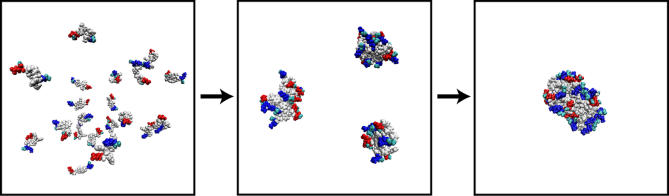
Representative Conformations in a Monte Carlo SimulationRepresentative steps in a Monte Carlo simulation of Aβ16–22 showing the coalescence of individual peptide molecules into aggregates.